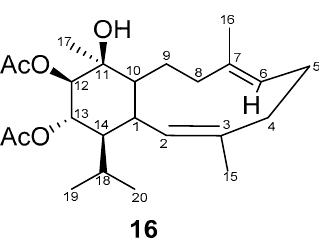
Figure 7. The 12,13-diacetoxycladiella-2,6-dien-11-ol ( 16 ) isolated from E. labiata .